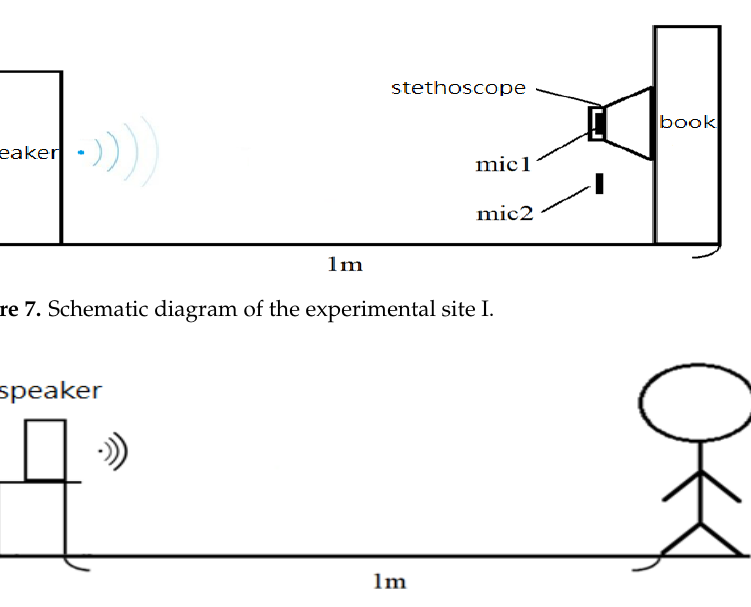
Figure 8. Schematic diagram of experimental site II.